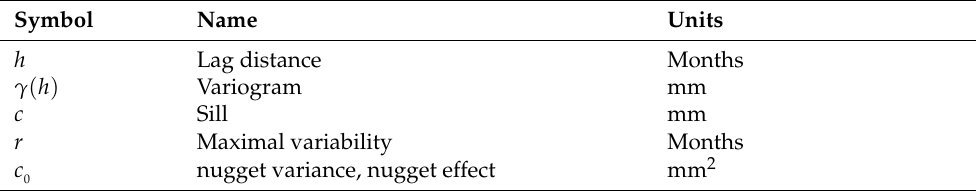
Table A1. Table of symbols and